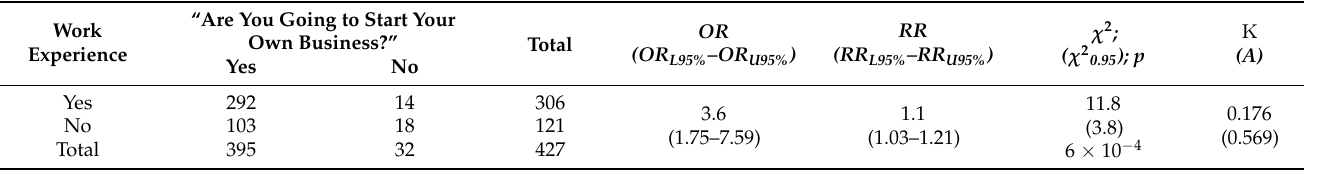
their own business indicates their high potential for entrepreneurial competence.